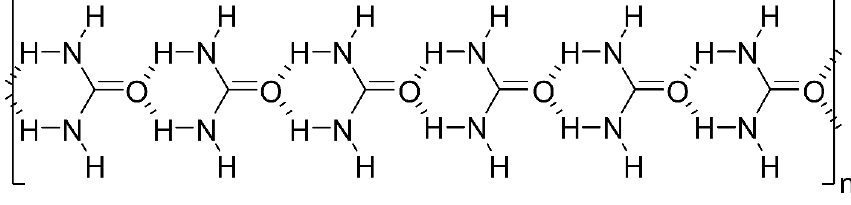
Figure 1. Hydrogen bond-mediated self-assembly of